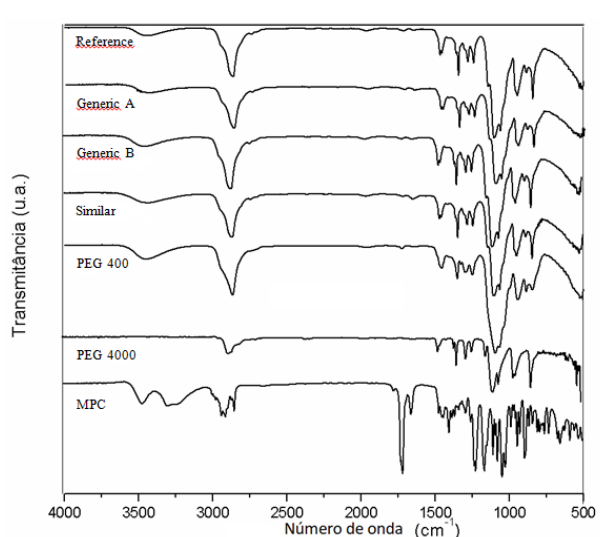
FIGURE 2 - FTIR-ATR spectra of MPC ointments, PEG 400, PEG 4000, and MPC drug.